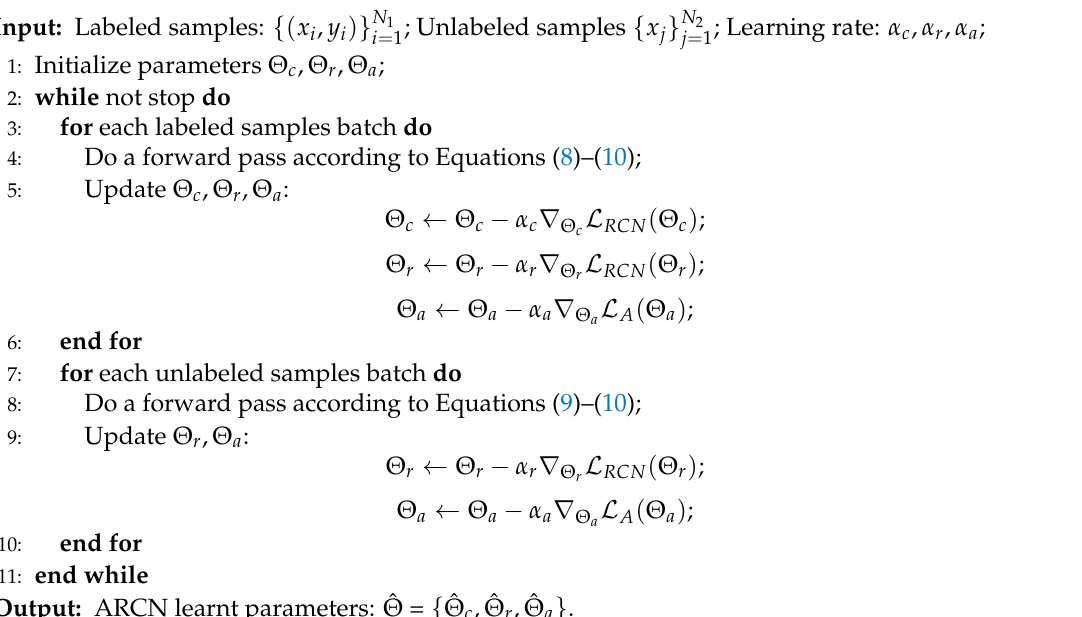
Algorithm 1 The adversarial reconstruction-classificati networks (ARCN) learning